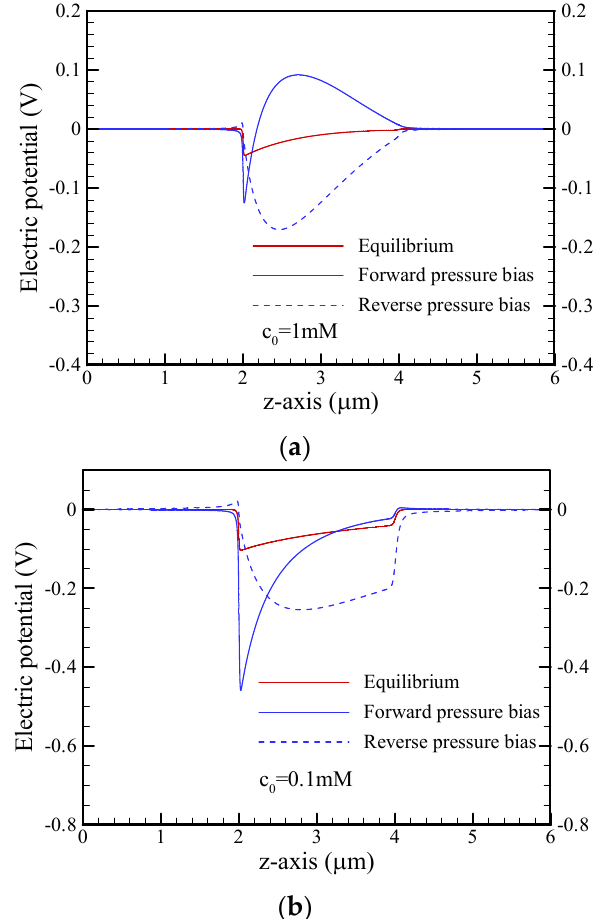
Figure 6. Plots of the electric potential along the centerline of the conical nanopore under the short-circuit condition and a pressure bias of p ext = 500 kPa for different salt concentrations of ( a ) c 0 = 1 mM and ( b ) c = 0.1 mM. Note that θ = 1.2°, σ s = −5 mC/m 2 , and b = 20 nm.